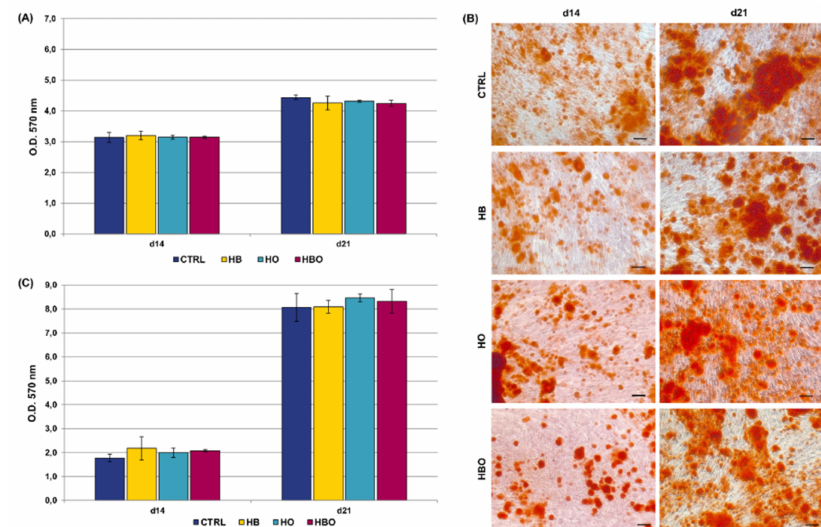
Figure 5. Metabolic activity and matrix mineralization of pre-committed hADSCs. ( A ) MTT assay of hADSCs 14 and 21 days after osteogenic di ff erentiation in ODM and HBO, HB, or HO treatment. Data are shown as mean ± SD ( n = 3). ( B ) ARS staining and ( C ), quantification of calcium deposits in hADSCs after d14 and d21 of culture in ODM and HBO, HB, or HO treatment. Scale bars 200 µ m. Data are shown as mean ± SD ( n =